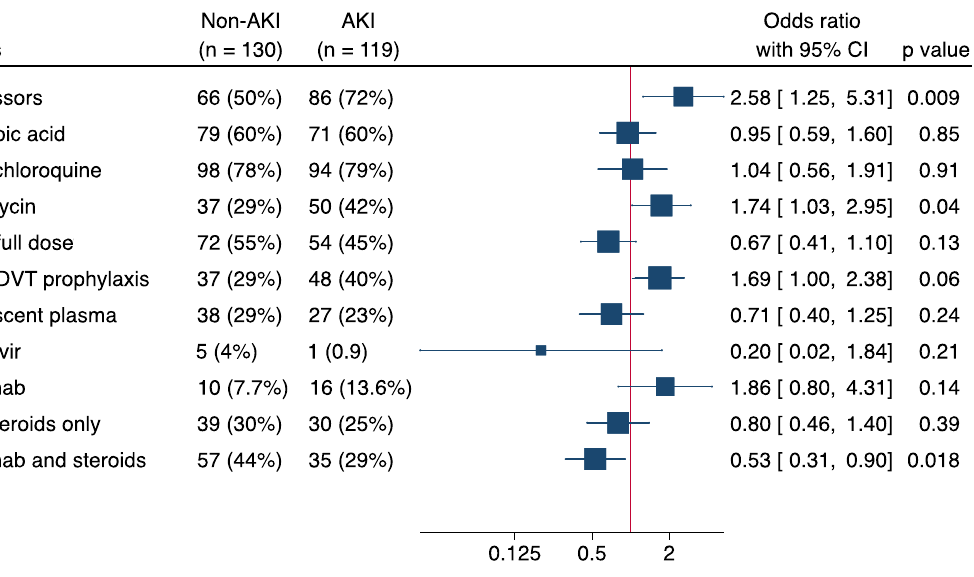
Figure 1. Forest plot depicting the effect of the indicated pharmacologic interventions on the odds ratio (OR) for developing AKI as determined by univariate analysis . Table 2. Pharmacological interventions in COVID-19 ICU patients with and without AKI.